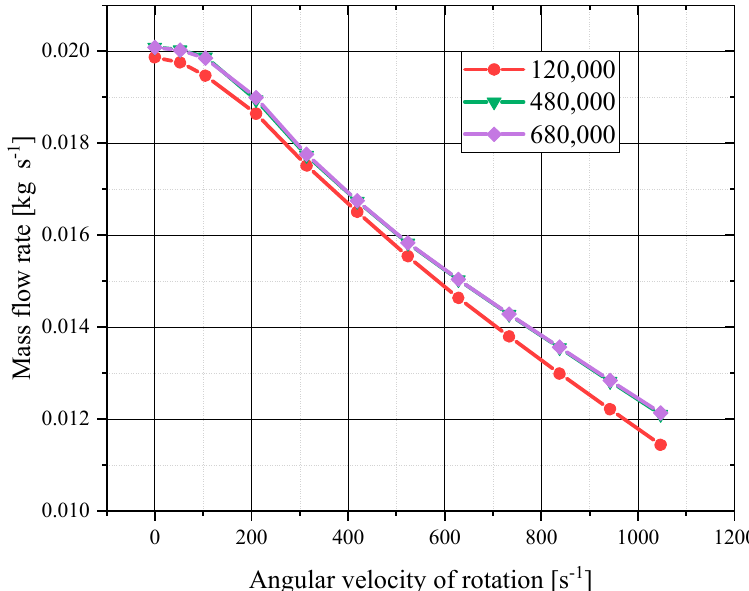
Figure 10. Verification of mass flow rate.